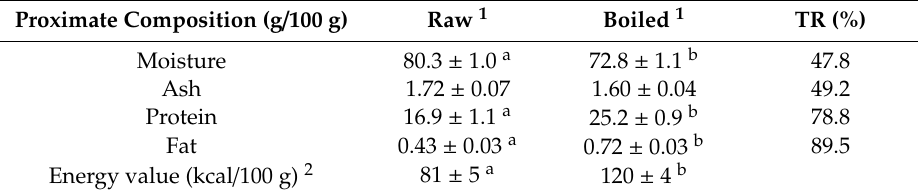
Table 3. Proximate composition, energy value, and true retention (TR) of common